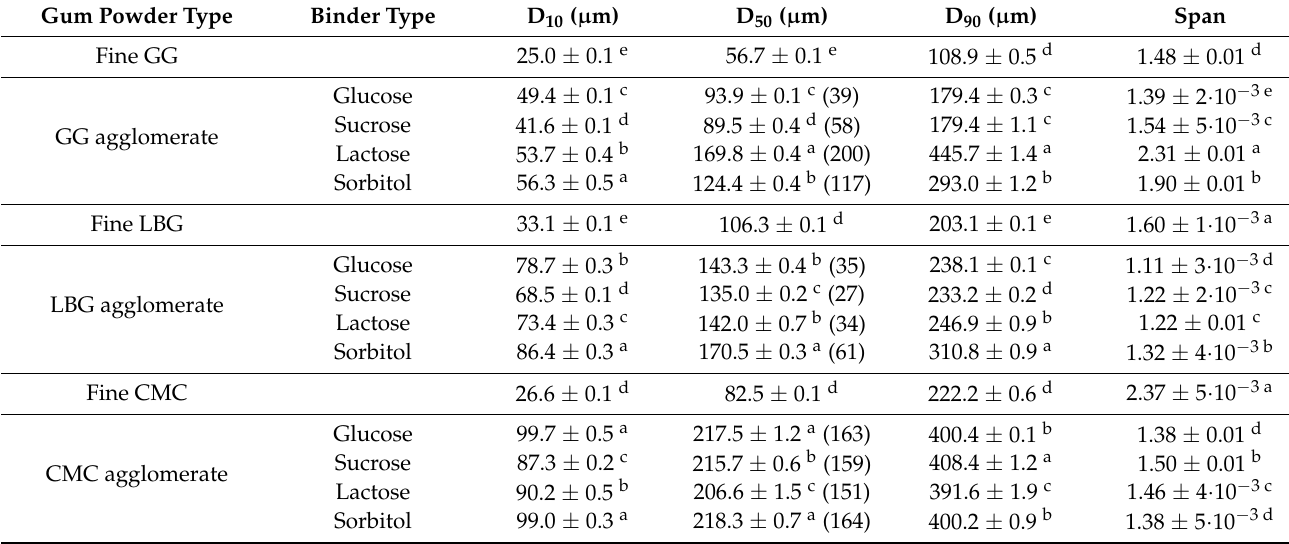
Table 1. Particle size distribution of fine gum powders and gum agglomerates (GG, LBG, and CMC) with different sugar binders. Gum Powder Type